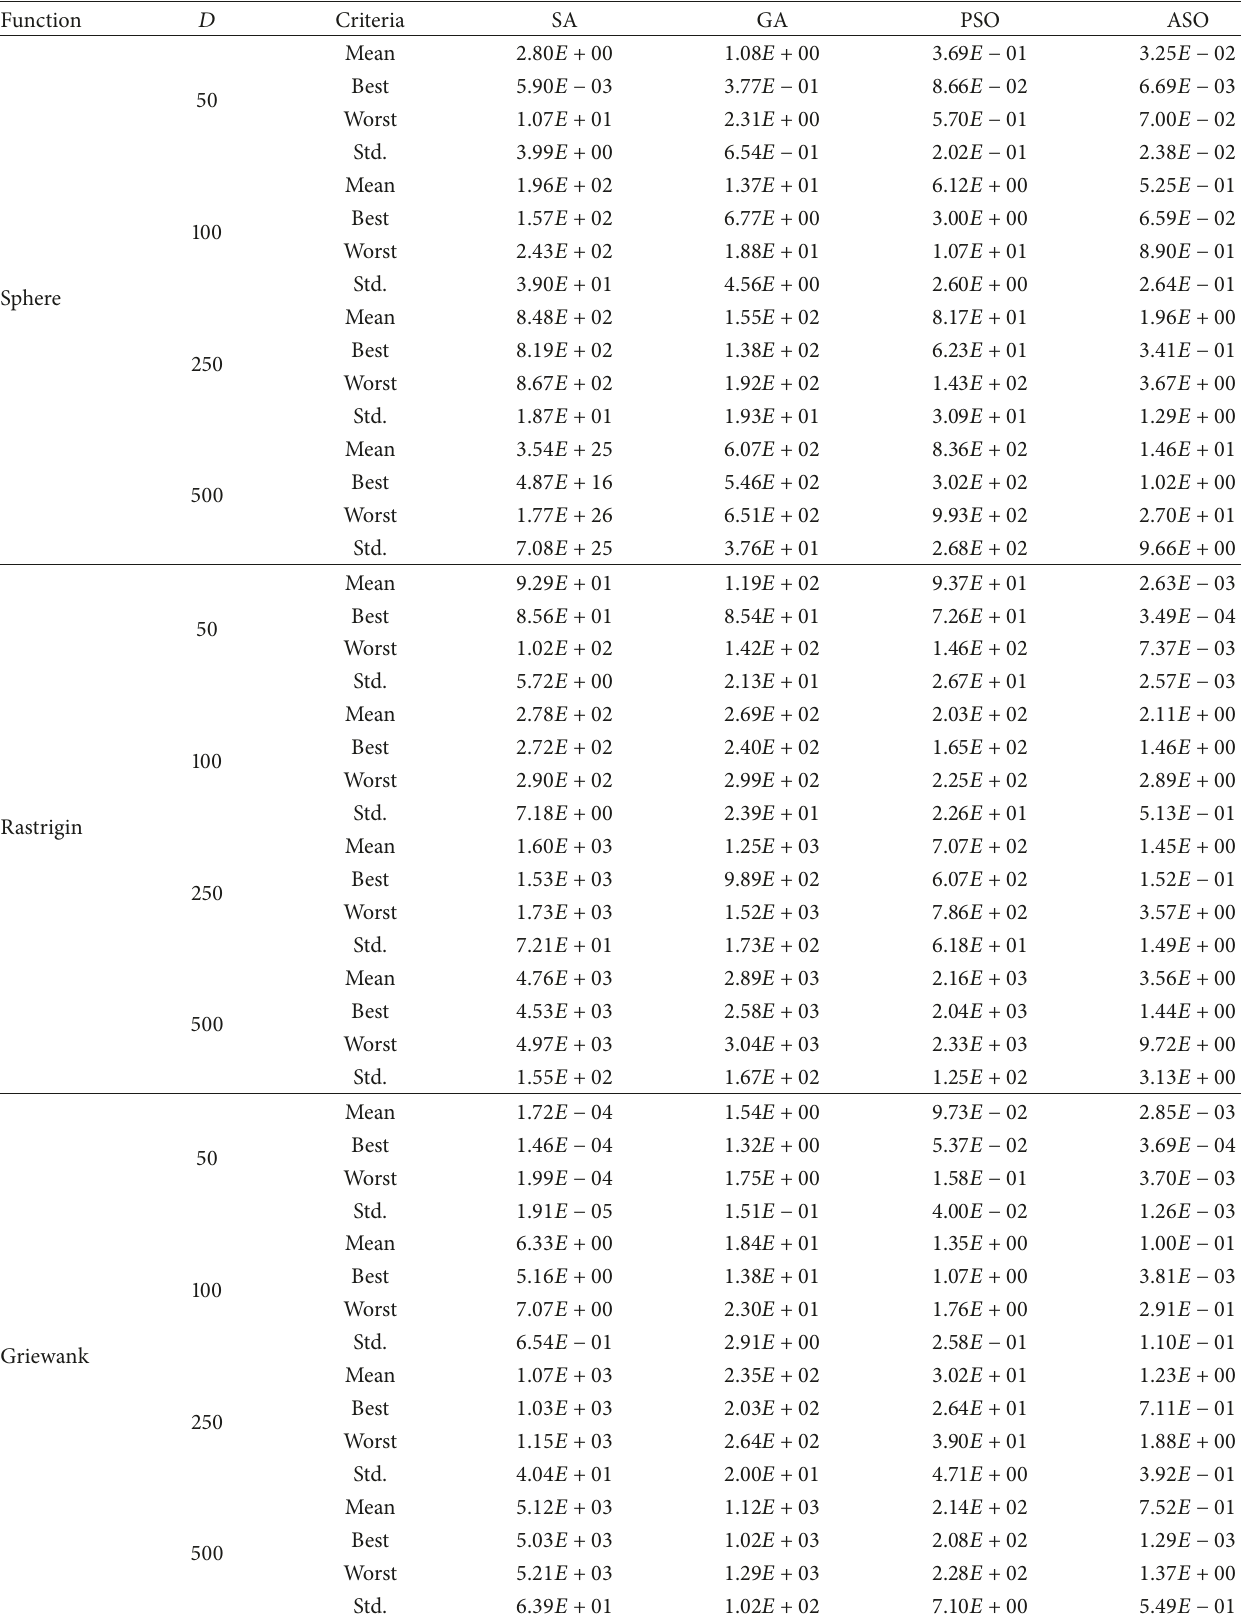
Table 3: Comparison of the results obtained by different algorithms.